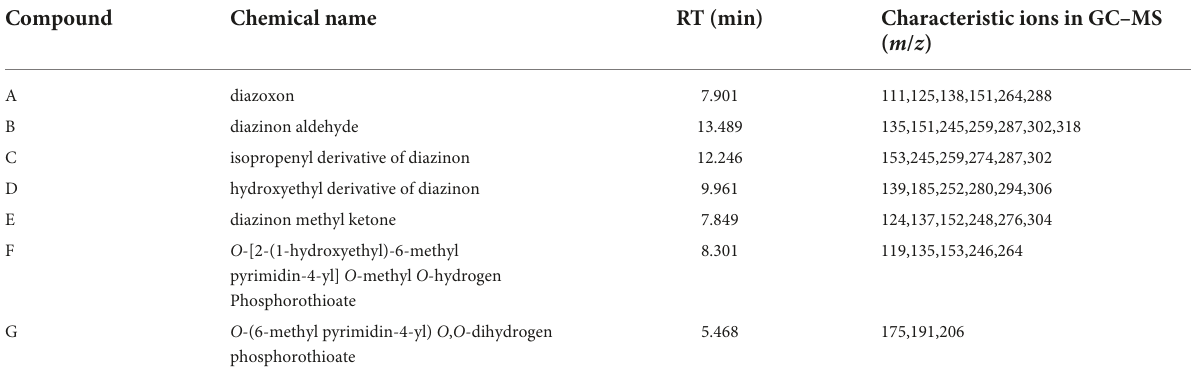
TABLE 1 Diazinon metabolites identified by gas chromatography/mass spectrometry (GC–MS).